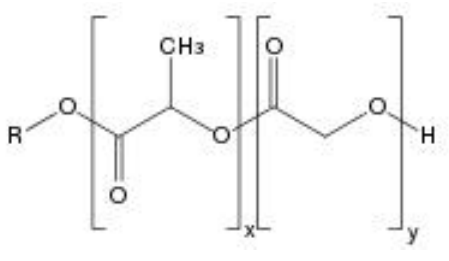
Figure 1. Structure of poly lactic- co -glycolic acid (x is the number of lactic acid units and y is number of glycolic acid